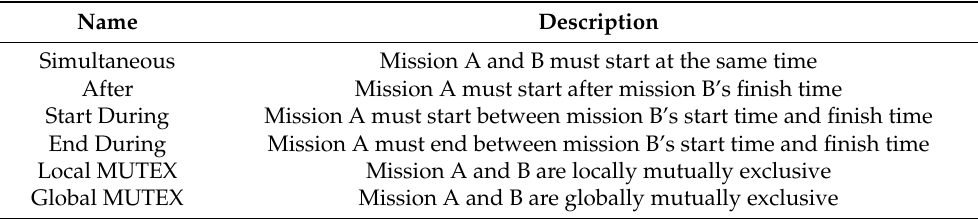
Table 2. Supported type of constraints in